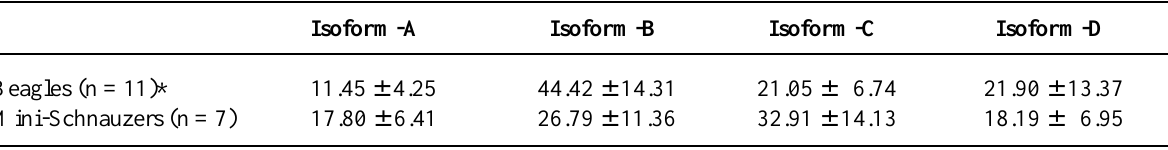
Table 3 – Distribution ratios (%) of 4 nephrocalcin isoforms.